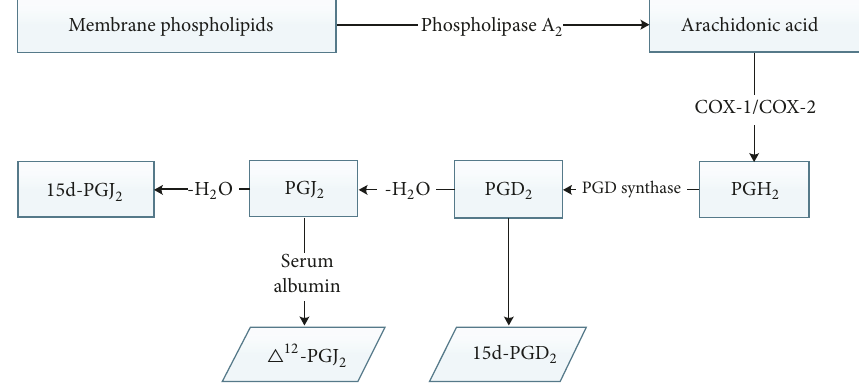
Figure 2: Biosynthesis of 15d-PGJ2.